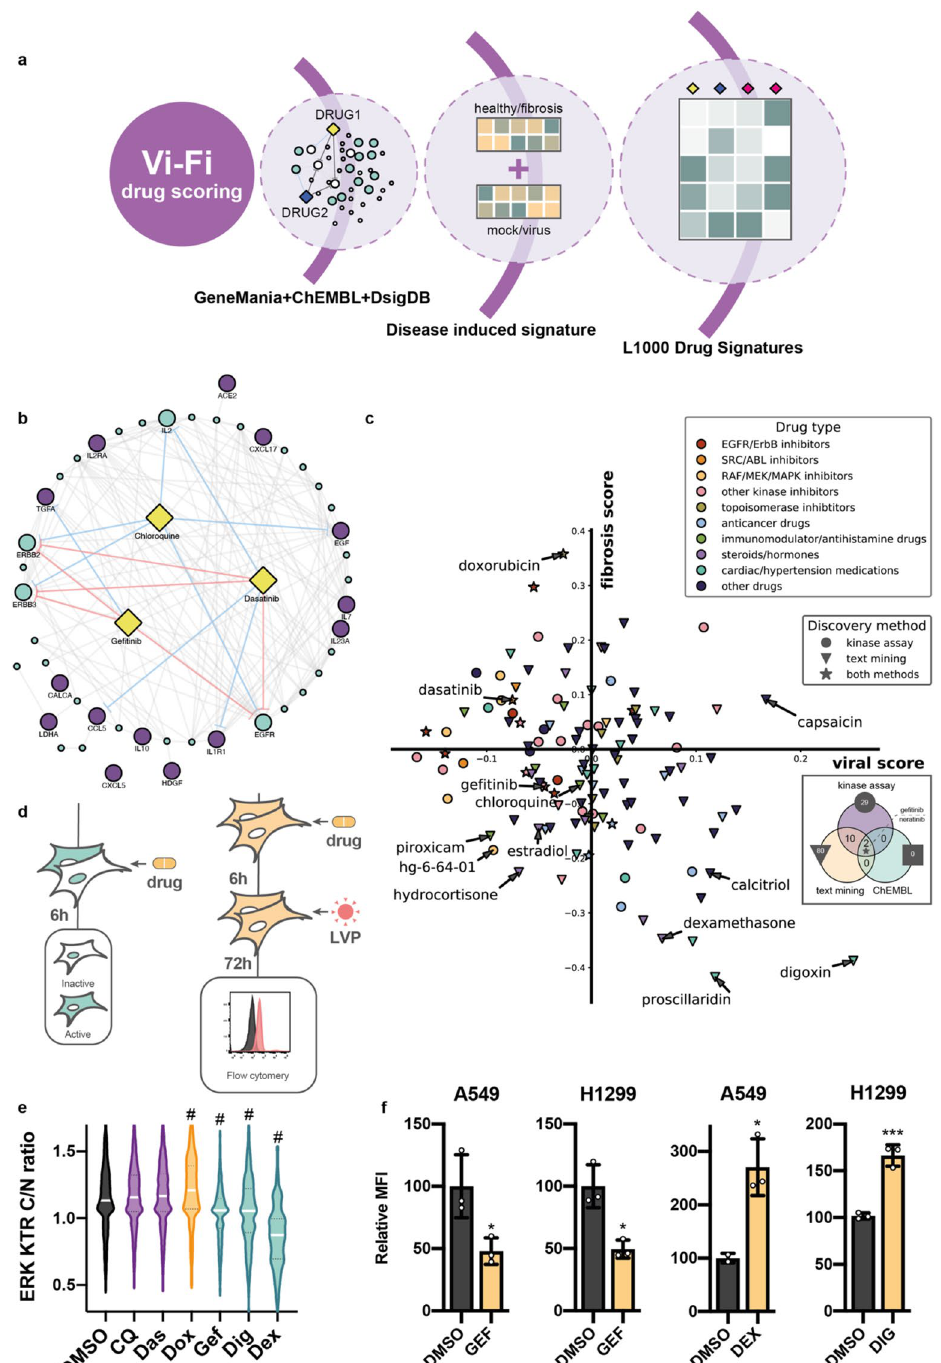
Figure 3. Vi-Fi drug repurposing and Vi-Fi evaluation in vitro. ( a ) Scheme of the method. ( b ) GeneMania network of potential drug targets relative to our panel of 14 SARS-CoV-2 profibrotic genes (violet nodes) and 32 additional genes predicted by GeneMania (blue nodes). A full list of genes is provided in Supplementary Table S4. The predicted interaction of gefitinib (GEF), dasatinib (DAS), and chloroquine (CQ) with proteins in the network. Red lines indicate direct inhibition determined by kinase activity assays and the blue lines—predicted inhibitory (text mining). ( c ) Scatter plot with predicted effects of drugs on SARS-CoV-2 infection (viral score) and fibrosis development (fibrotic score). Types of drugs are marked by colors concerning their medical usage, the primary target, or general mechanisms of action. Circles—drugs with proven inhibitory activity against at least one protein in the network (ChEMBL or DSigDB), diamonds—text mining (DSigDB), and stars—both methods. Venn diagram represents number of drugs available at L1000 revealed by each method. ( d ) Schemes of the experiments. ( e ) Violin plots of ERK activity in A549 ERK-KTR cells. Cells were treated with 5 µM CQ, 25 nM DAS, 25 nM doxorubicin (DOX), 5 µM GEF, 25 nM digoxin (DIG) and 10 µM dexamethasone (DEX) for 6 h. ( g ) Relative MFI of cells treated with 5 µM GEF, 10 µM DEX, and 25 nM digoxin (DIG). P-value is calculated relative to DMSO- treated sample. ( f ) Relative MFI of cells treated with GEF, DEX, and DIG. Error bars represent standard deviation from 3 independent biological replicates. LVP lentiviral particles. p-value for e was calculated by Mann–Whitney test, # p-value < 0.001. p-value for ( f ) was determined by unpaired t-test, *p-value < 0.1, ***p-value <